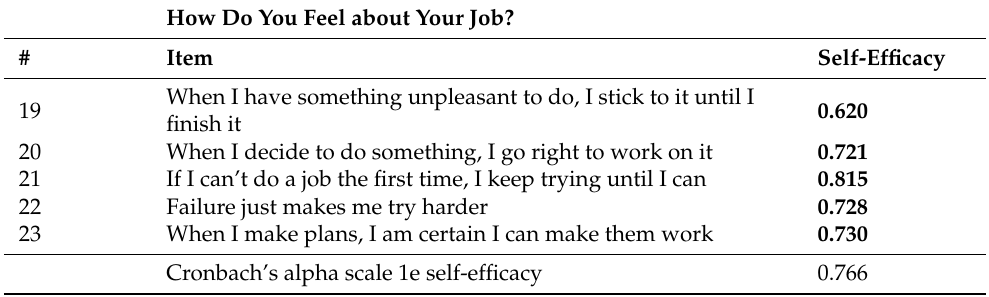
Table 3. Principal component analysis (PCA), MAISE-Easy Area 1—Level of SE (self-efficacy). How Do You Feel about Your